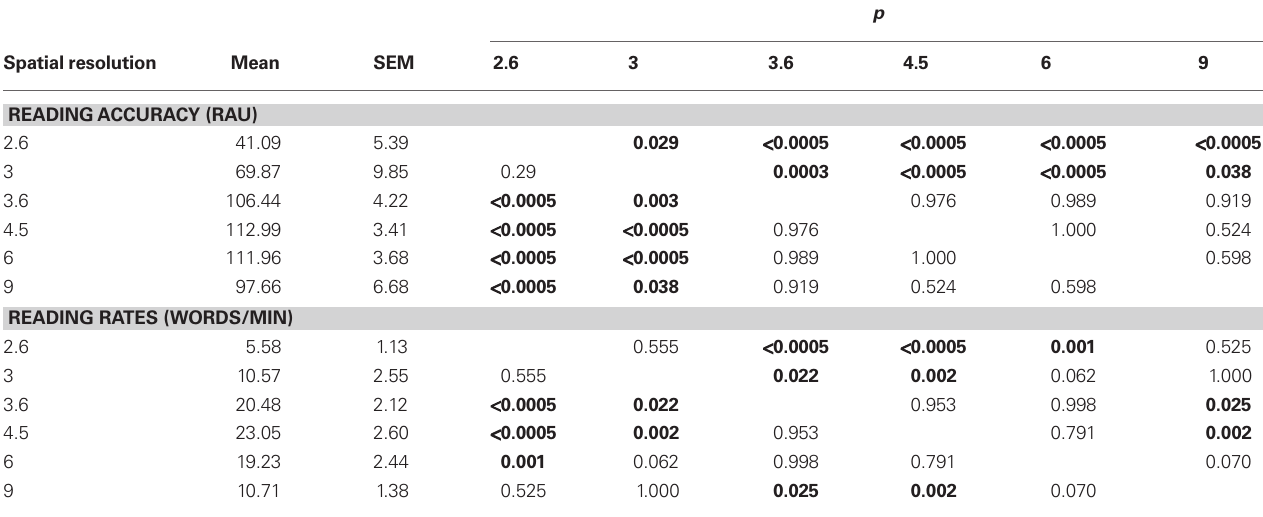
Significant p-values ( < 0.05) are highlighted in